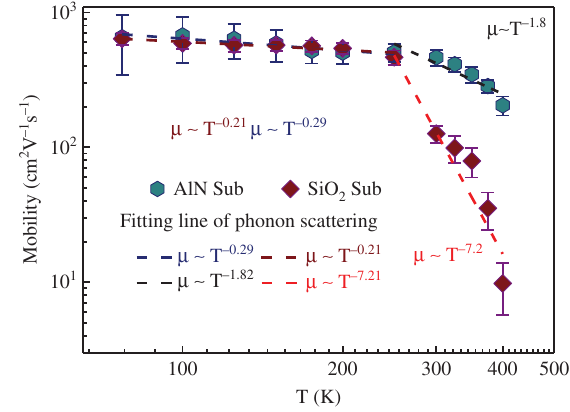
) of BP FETs on AlN/SiO /Si and Figure 4: Field-effect mobility ( μ FE 2 SiO /Si substrates as a function of temperature. The mobility was 2 suppressed because of phonon scattering limited transport, which ~ T − θ , where the exponent depends on the dominant follows μ FE scattering mechanism. The dashed lines are fitting results according to this law, where the θ is about 0.2 ~ 0.3 at low temperatures within 77–250 K and increases rapidly at high temperatures, indicating the intense phonon scattering between carriers and lattice. The θ for BP FETs on the AlN substrate is much smaller than that on the SiO 2 substrate, suggesting a modest scattering intensity at the interface between AlN and